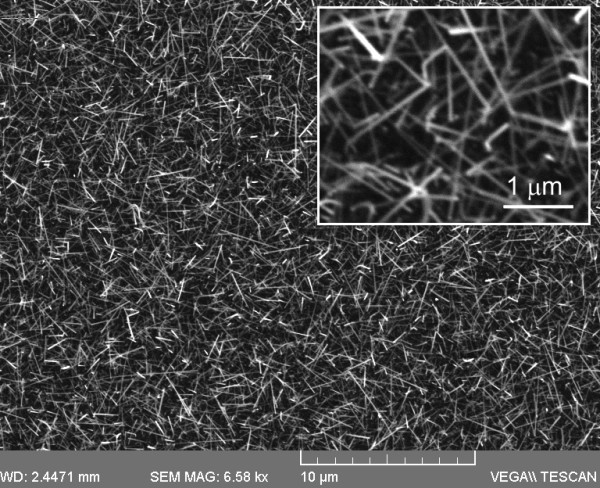
Typical SEM image of In2O3 NWs obtained on 1.1 nm Au/Si(001).